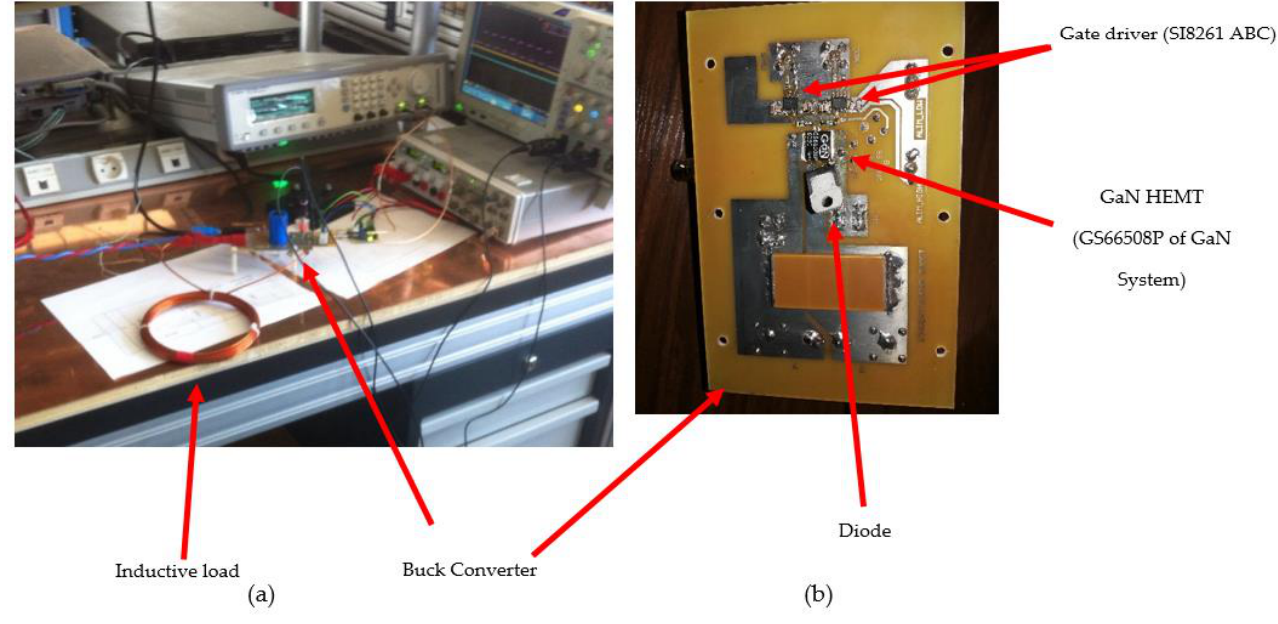
Figure 4. ( a ) Test setup and ( b ) the prototype.